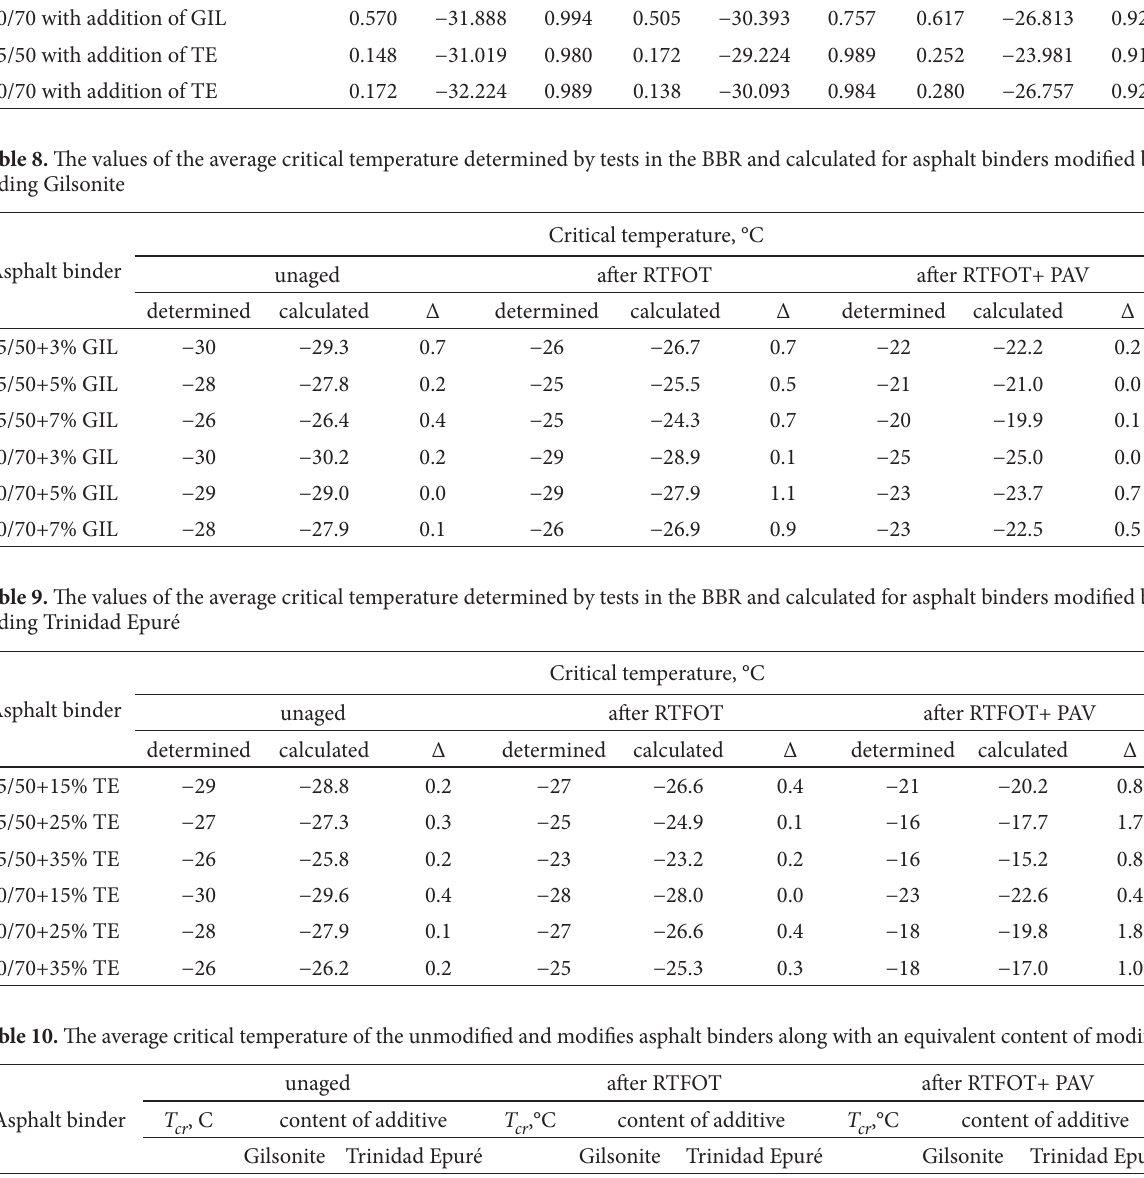
Table 7. The values of the coefficients a, b and R 2 of the linear regression determined for the dependence of the critical temperature mean value on the content of the Gilsonite and Trinidad Epuré additives